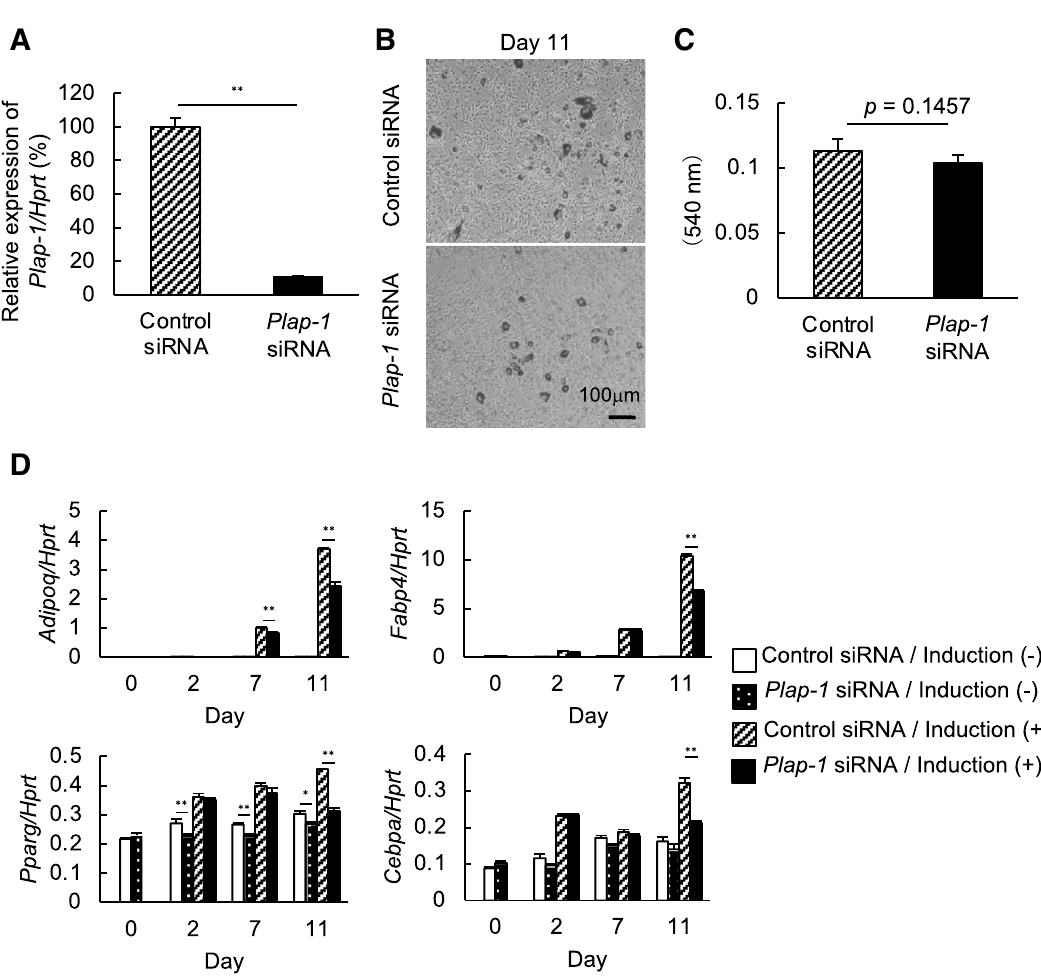
Figure 4. Adipocyte differentiation of Plap-1 knock-down 3T3-L1 cells by siRNA. ( A ) Real-time PCR analysis was performed to confirm Plap-1 knock-down by siRNA in 3T3-L1 cells. Data are represented as relative expression to control siRNA. Values represent the mean ± SD triplicate assays (n = 3). ( B ) Oil Red O staining of Plap-1 knock-down and control 3T3-L1 cells was conducted after adipocyte differentiation. ( C ) Quantitative lipid assay of Plap-1 knock-down and control 3T3-L1 cells was performed after Oil Red O staining ( n = 4 in each group). Values represent the mean ± SD (n = 4). ( D ) Real-time PCR analysis was performed to examine adipogenic gene expressions of Plap-1 knock-down 3T3-L1 cells during adipocyte differentiation. Results show the mean ± SD of triplicate assays (n = 3). *: p < 0.05, **: p <